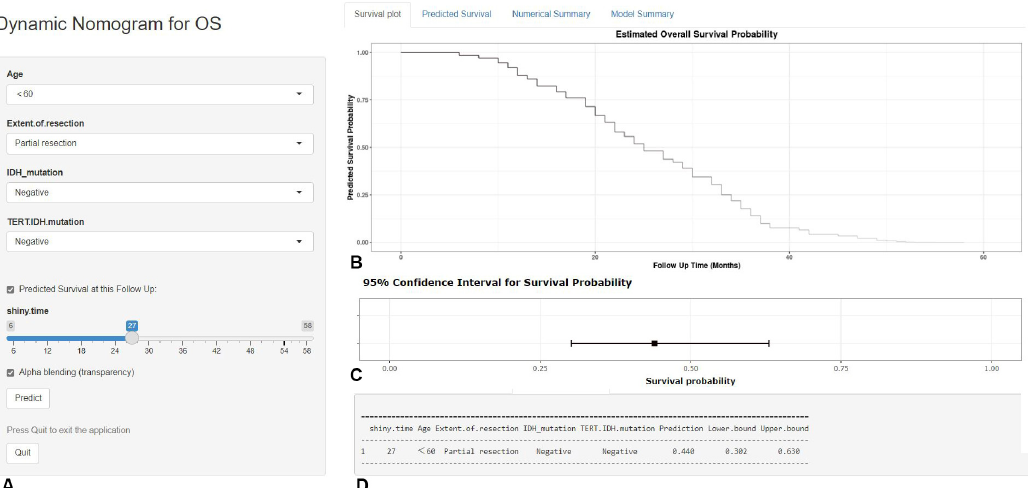
Figure 7. The screenshot of the online dynamic nomogram for PFS. After designating the items ( A ), neurosurgeons could easily plot the survival curve for an individual patient ( B ), predict the survival rate at each time point ( C ), and view the model summary ( D ).